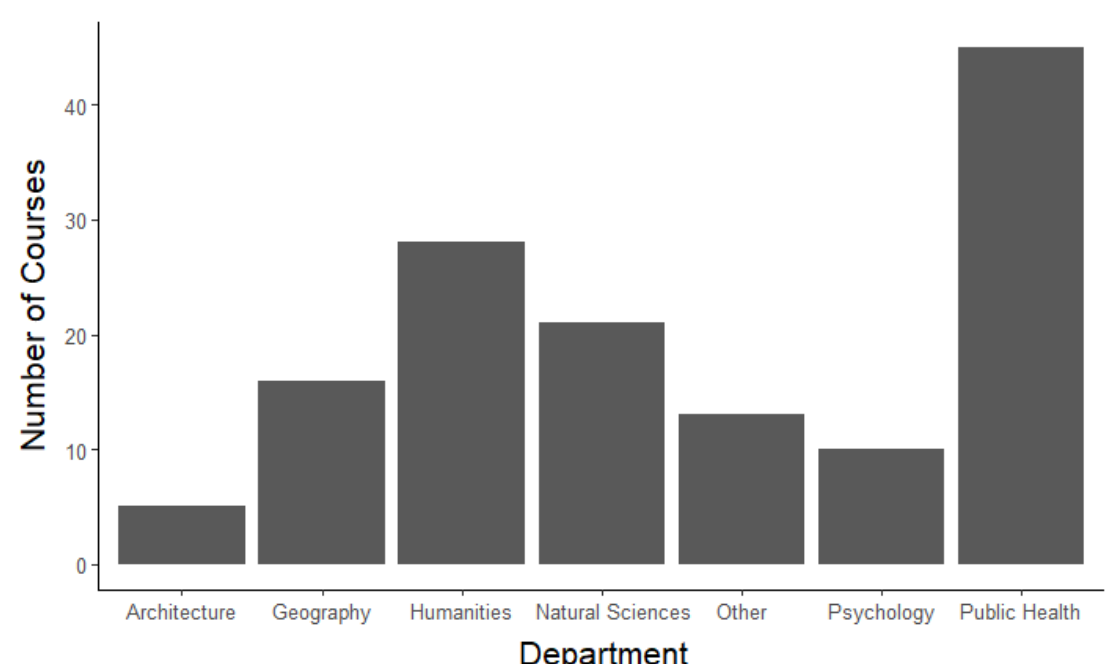
Figure A 2 .1: Number of disaster-related course offerings per department, based on sampled universities that had courses relating to disasters (n = 68).